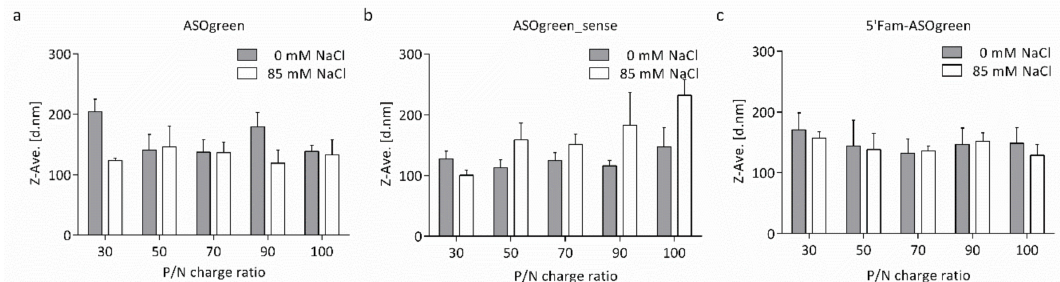
Figure 1. The Z-average hydrodynamic diameter of CS–ASO nanocomplexes at varying P / N charge ratios. The size of CS–ASO nanocomplexes with ( a ) ASOgreen, ( b ) ASOgreen_sense and ( c ) 5 (cid:48) Fam-ASOgreen varied between 100 and 200 nm. On average, nanocomplexes prepared in the presence of 85 mM NaCl were smaller than nanocomplexes prepared without NaCl ( n = 3).